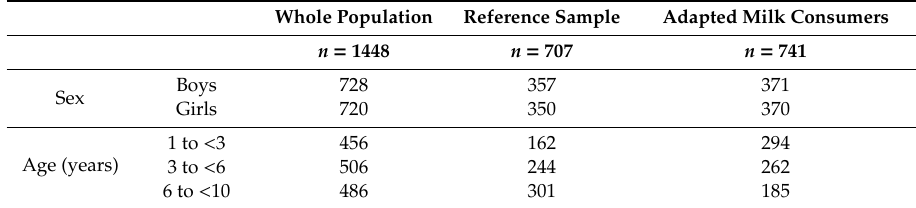
Table 2. Distribution of the studied sample in the Nutritional Study in Spanish Pediatric Population (EsNuPI) ( n =